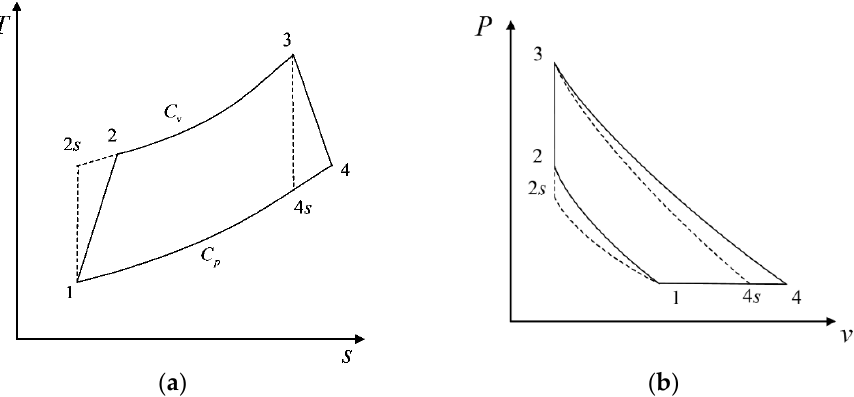
Figure 1. ( a ) T s  representation of Atkinson cycle [62]. ( b ) p v  representation of Atkinson cy- Figure 1. ( a ) T − s representation of Atkinson cycle [62]. ( b ) p − v representation of Atkinson cle.